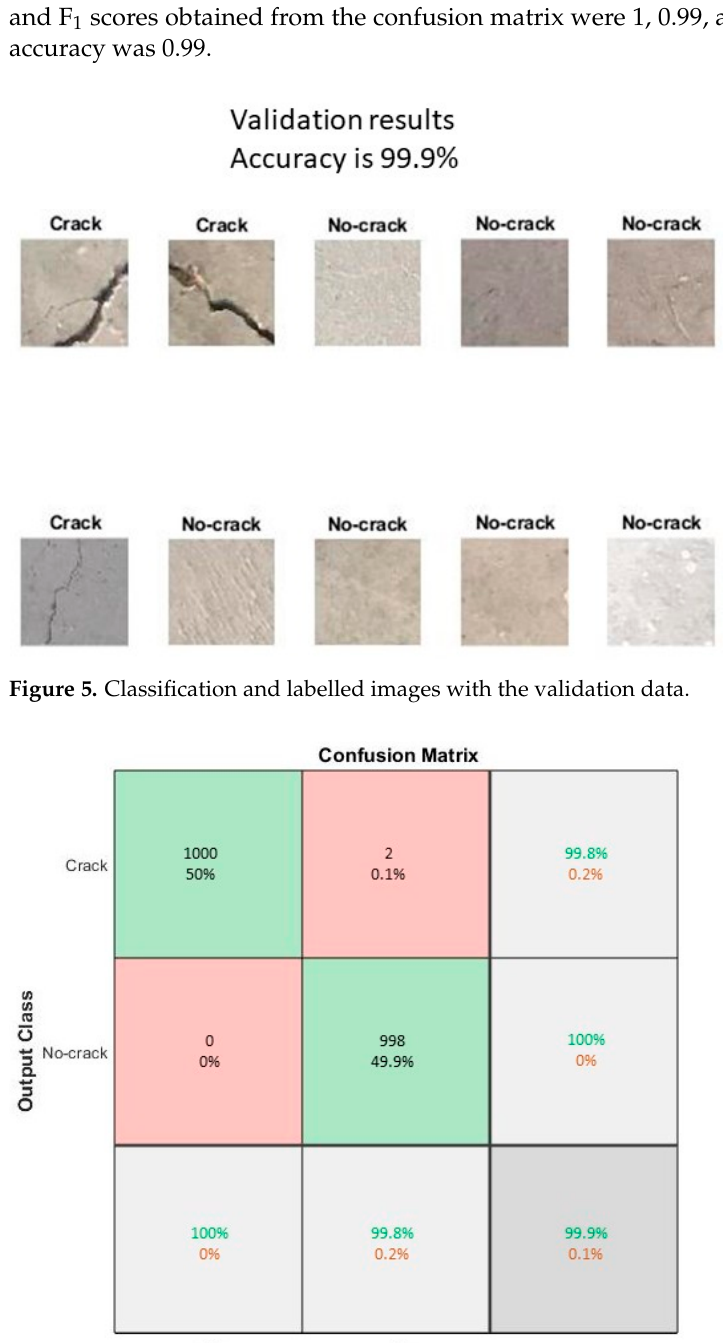
Table 5. Performance metrics of the validation images.